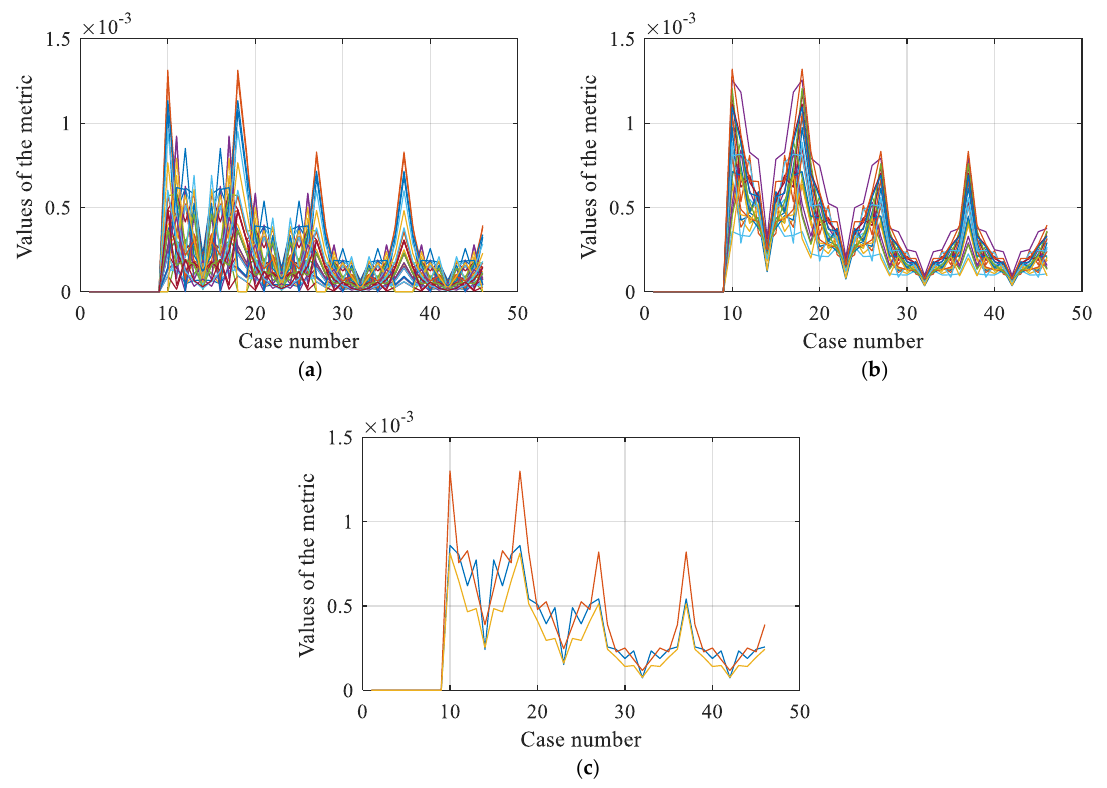
Figure 9. Damage detection results: ( a ) p is equal to 1; ( b ) p is equal to 7; ( c ) p is equal to 17.